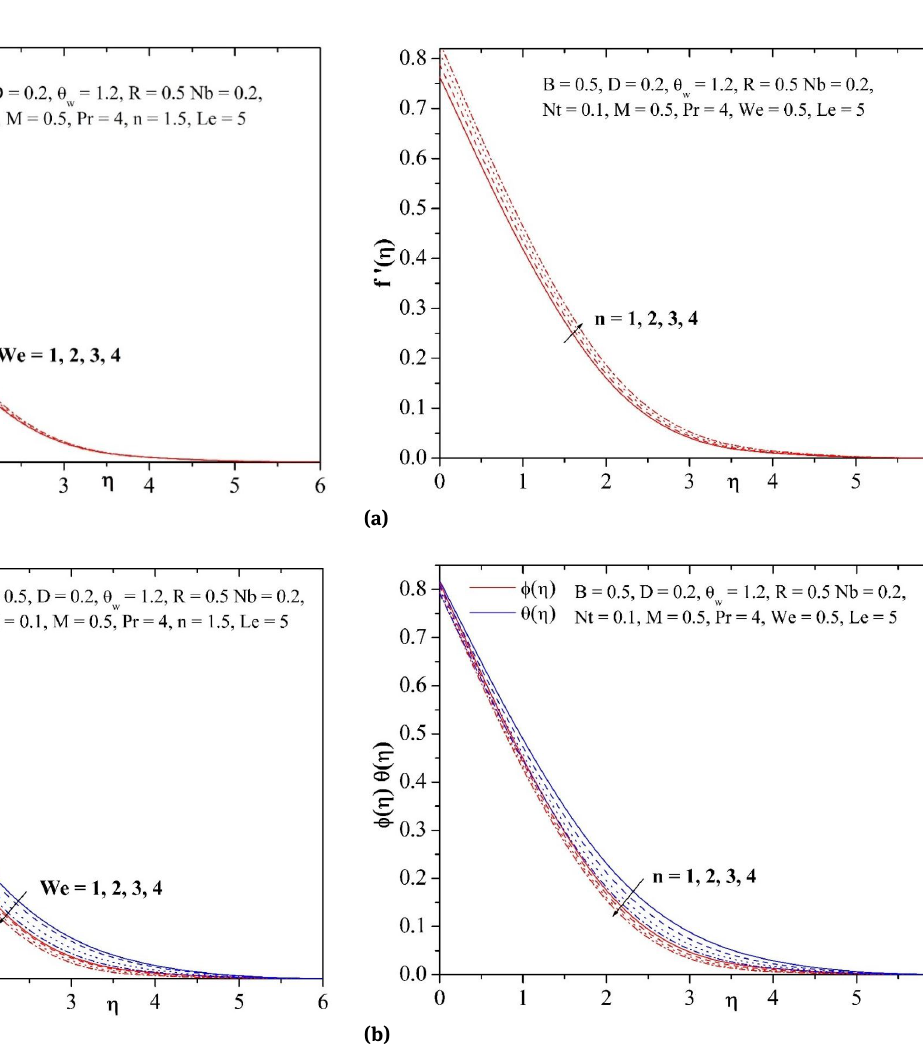
Fig. 2: (a) Influence of We on velocity profile. (b) Influence of We on temperature and concentration profiles.